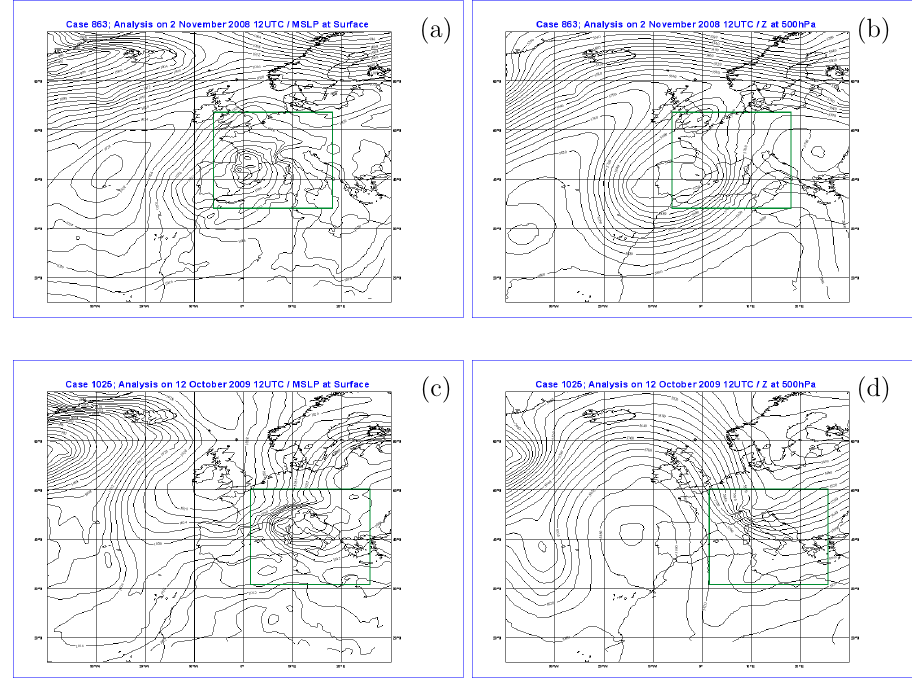
Fig. 1. Top: MSLP (left panel) and 500hPa geopotential height (right panel) analyses for case 863 (event c). Bottom: like top panels but for case 1025 (event f). The analyses are derived from EXP-RS. The green box is the verification area for the corresponding